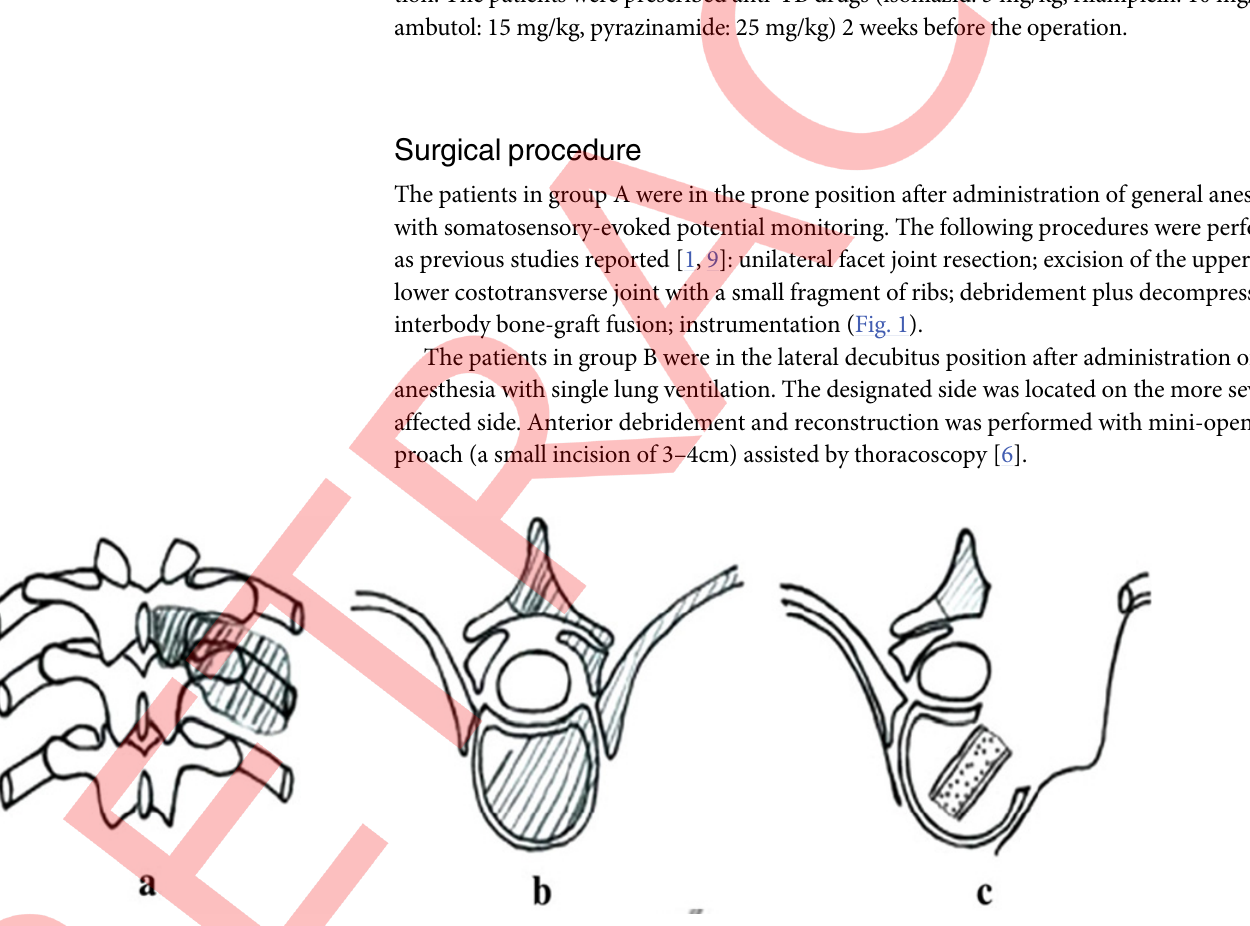
Fig 1. Illustration of surgical management for tuberculous spondylitis through posterior approach. The shaded parts are considered surgically resectable (a,b). C is the removal of the side of the facet joints, transverse joints and ribs, bone graft in lesions after the debridement.